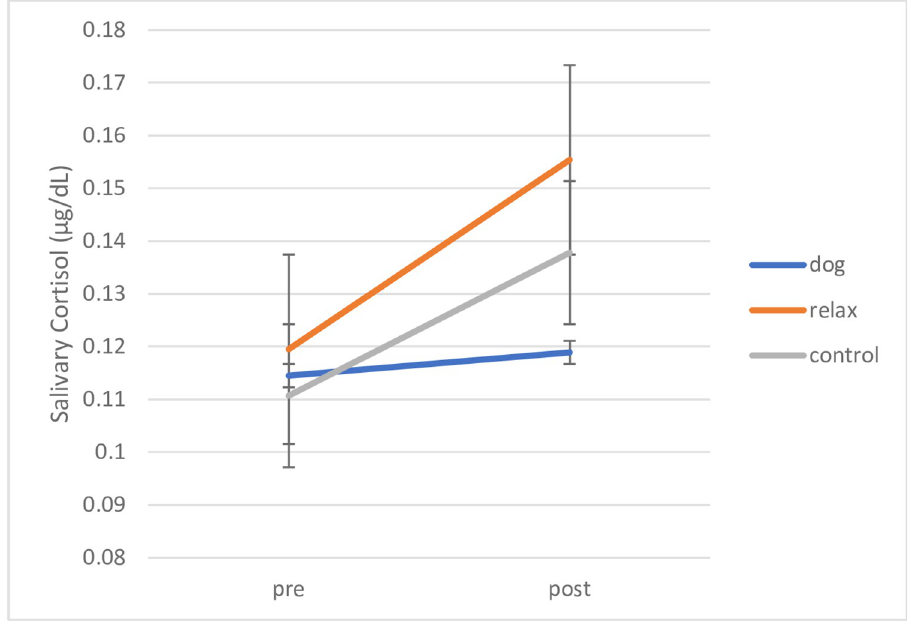
Fig 3. Mainstream cohort: Mean pre-post salivary cortisol by intervention condition. Mean pre-post salivary cortisol levels shown by intervention condition. Error bars indicate standard error of mean.